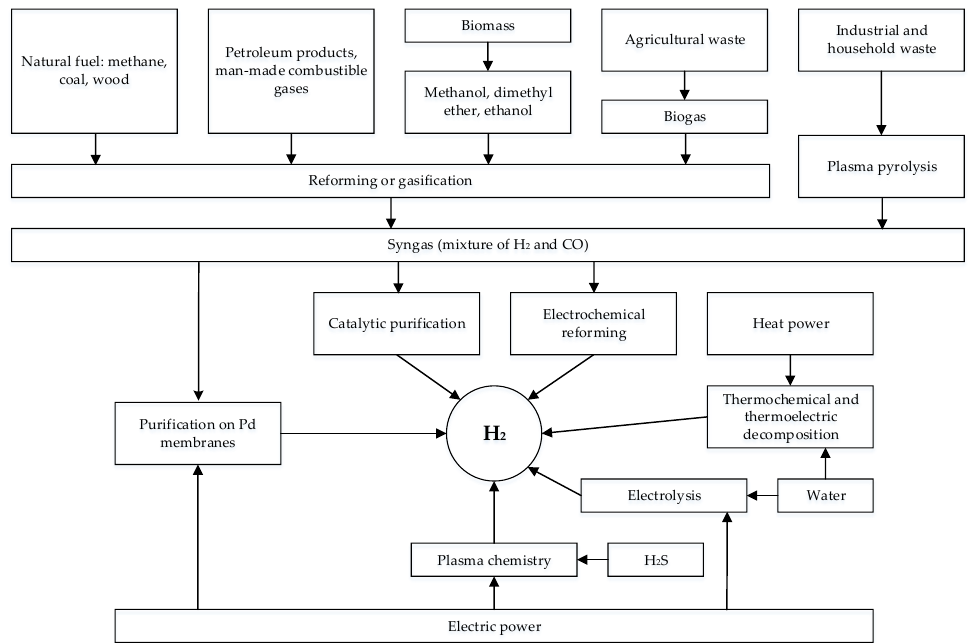
Figure 3. Possible sources and methods of producing hydrogen.